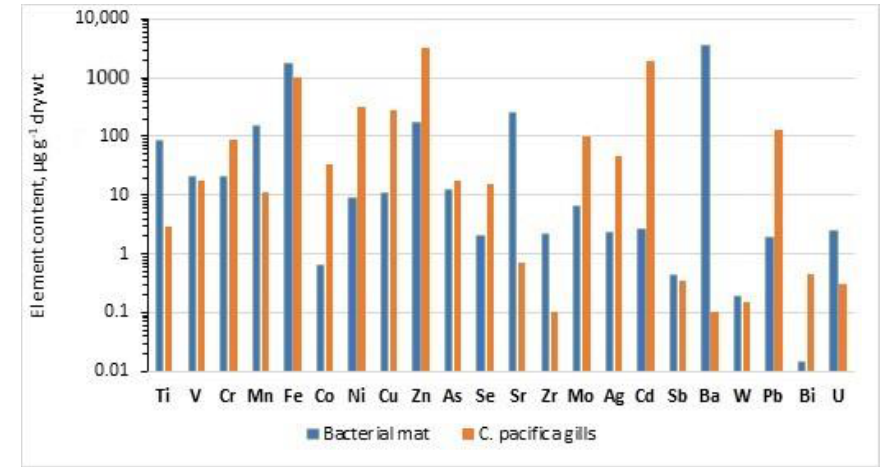
Figure 4. Comparison of the element distribution in bacterial mat and C. pacifica gills.